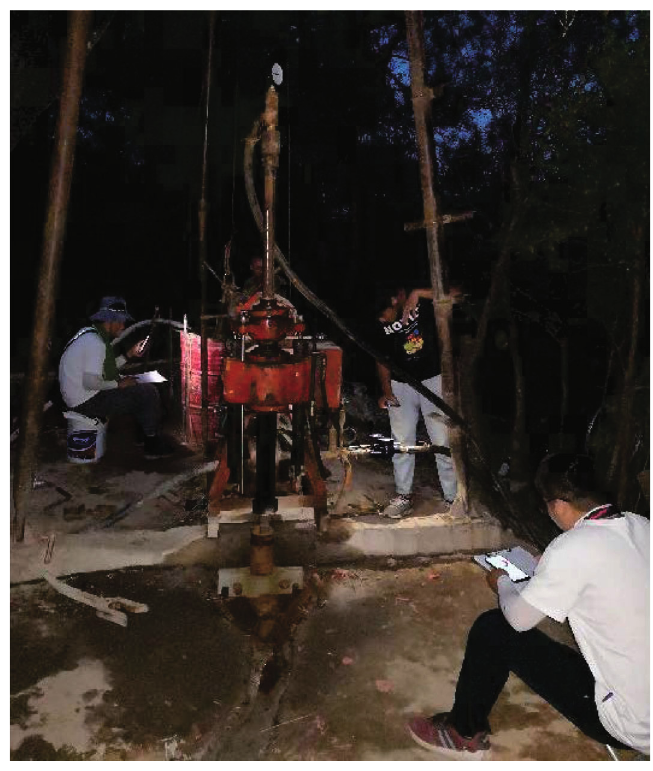
Figure 5: The water pressure test.